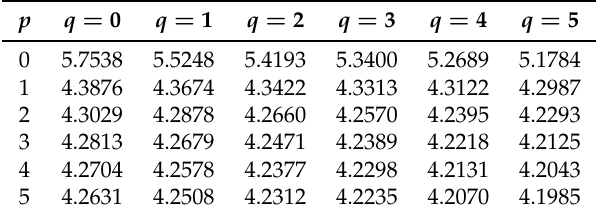
Table A6. Bit rates (bits/pixels), obtained for various values of p and q , on “Levada”.